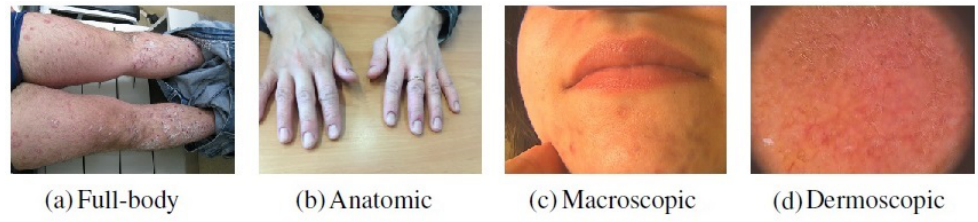
Figure 2. Examples of images from each image modality selected for the incremental